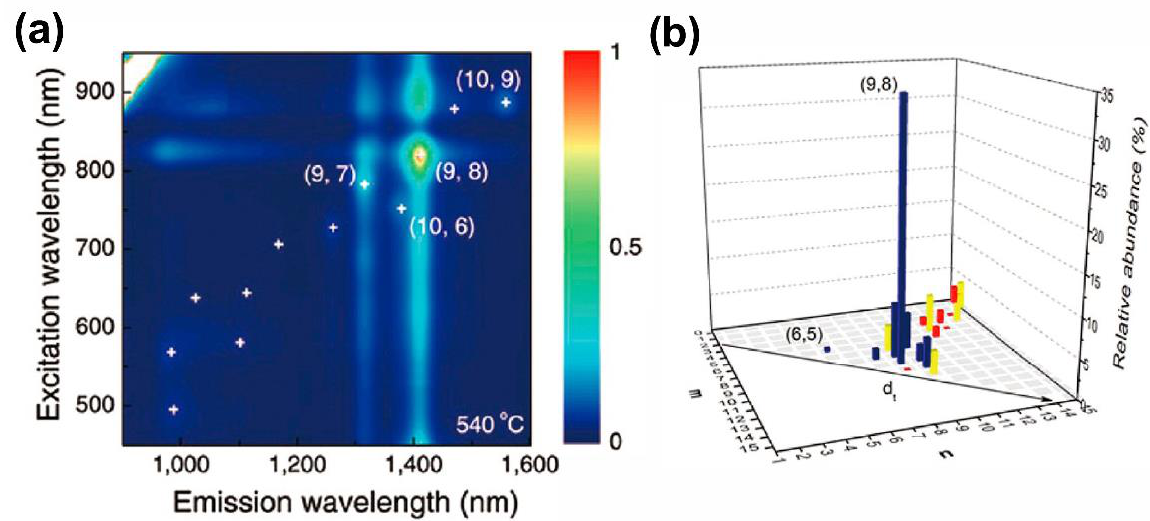
Figure 8. ( a ) PL intensity spectra of SWCNTs dispersed in 2 wt% sodium dodecyl benzene sulfonate (SDBS) D 2 O solution. ( b ) Abundance of (n,m) SWCNTs produced after CoSO 4 /SiO 2 catalyst reduction at 540 °C using PL (blue), Raman (red), and absorption (yellow) [59]. Copyright 2013, American Chemical Society.